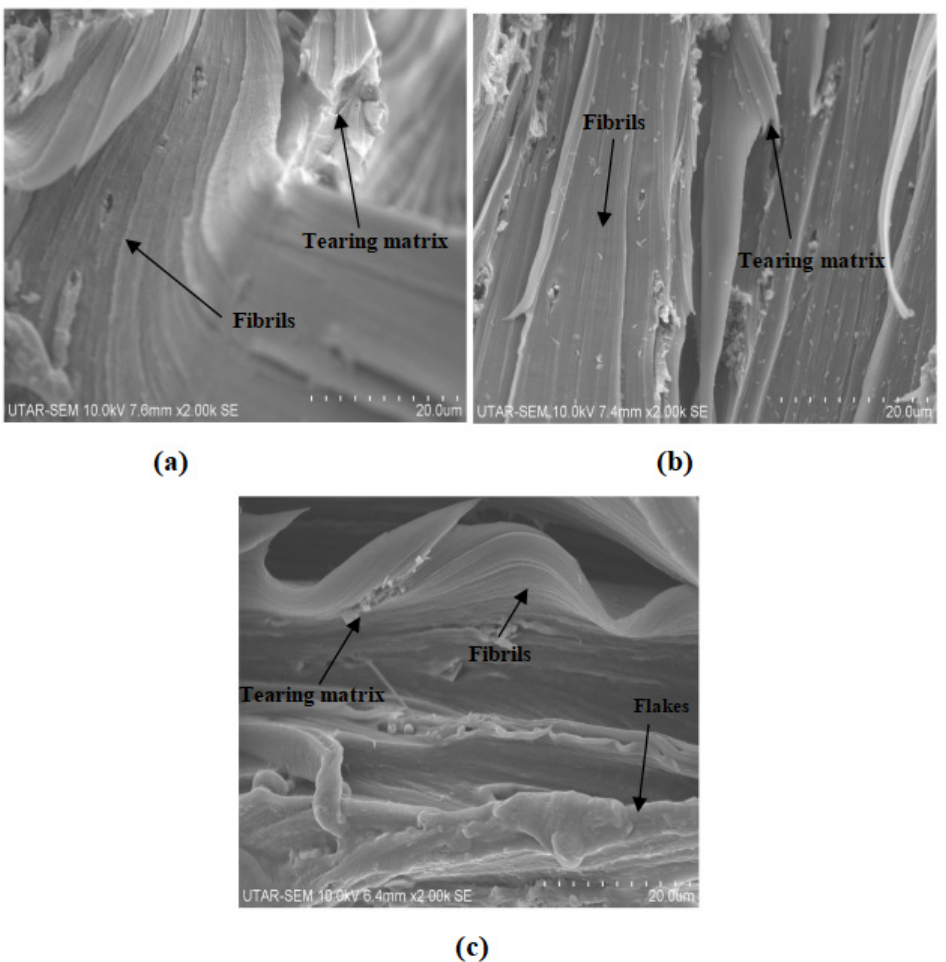
Figure 10. SEM of 5 phr calcined cuttlebone incorporated into the PVOH matrix added with ( a ) 1 phr MMT, ( b ) 2 phr MMT, and ( c ) 3 phr MMT.